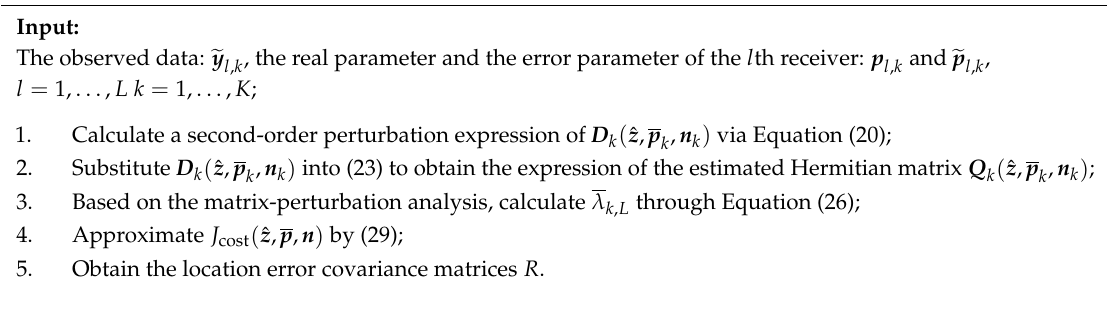
Algorithm 1. The main steps of the analysis